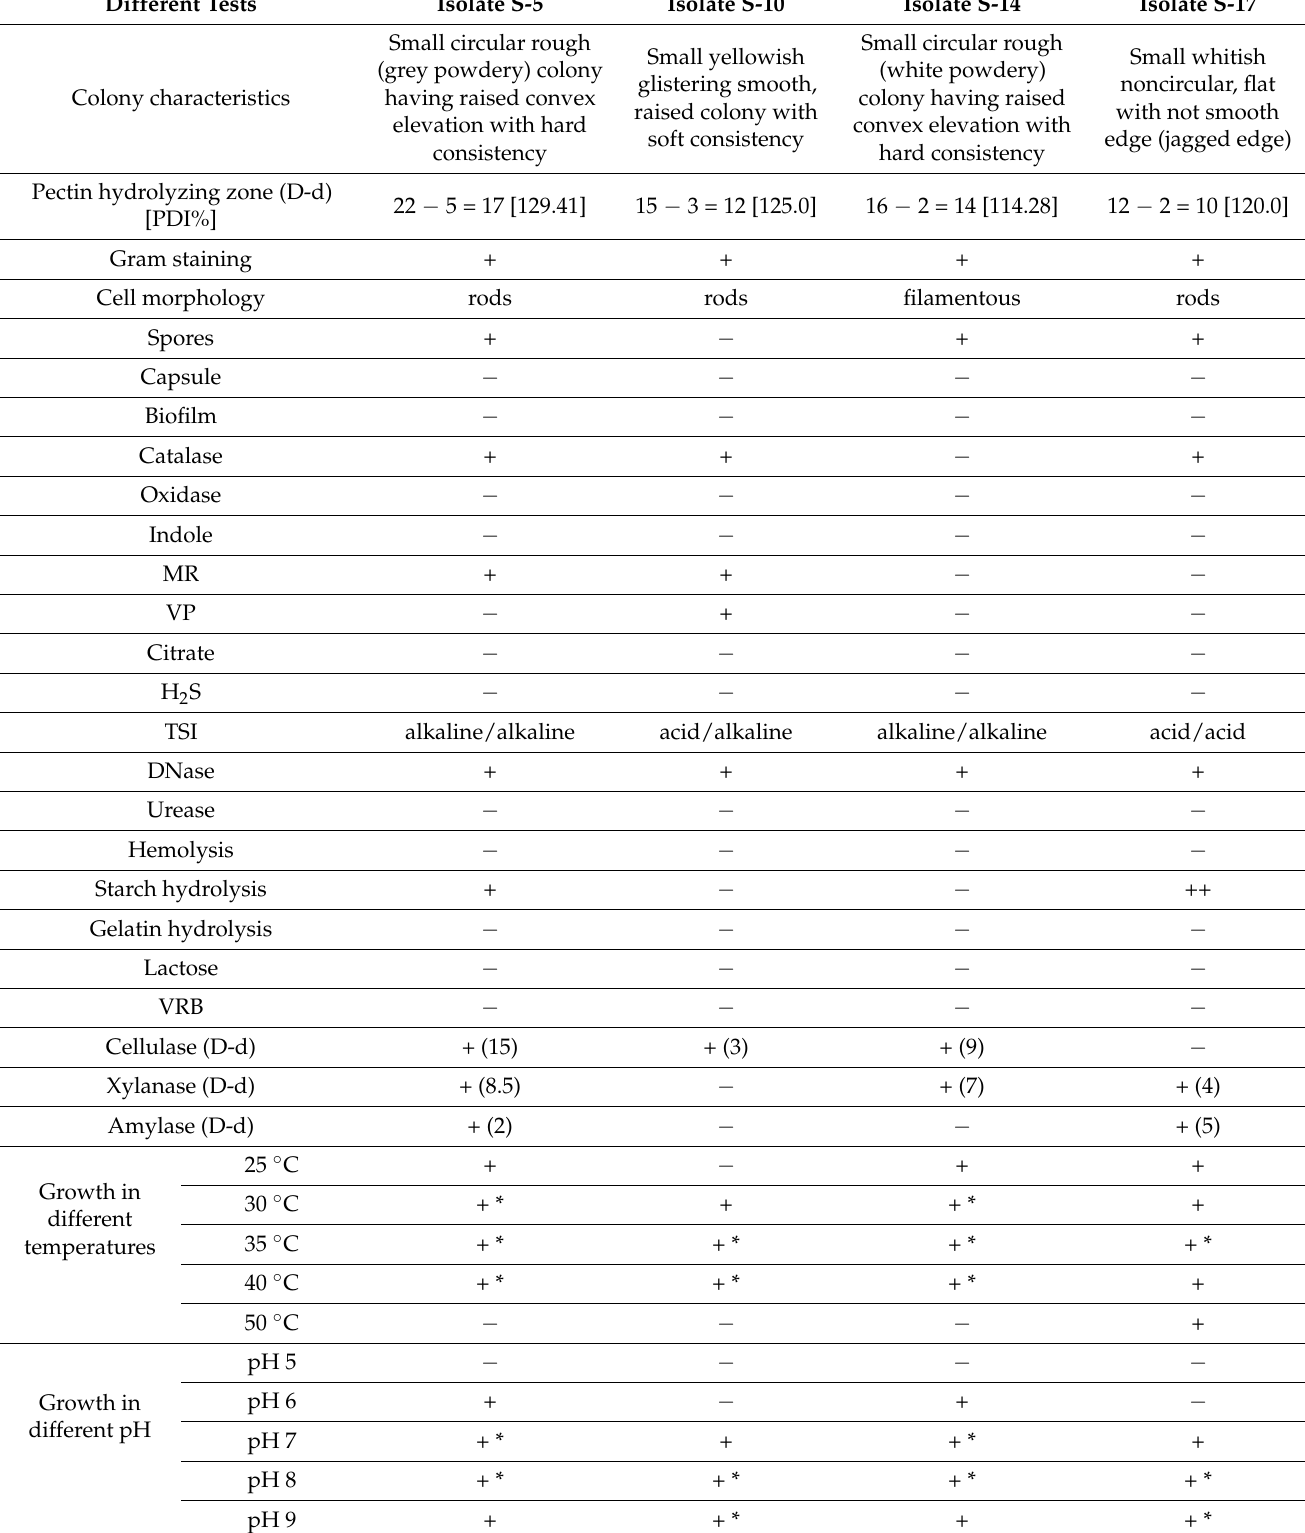
Table 1. Different tests result of the four selected isolates with pectinolytic